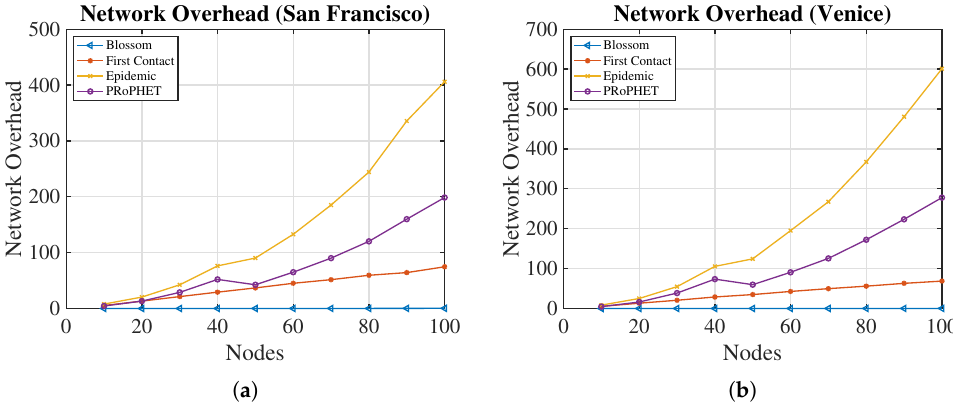
Figure 7. Comparison of routing algorithms for network overhead ratio. ( a ) San Francisco; ( b )